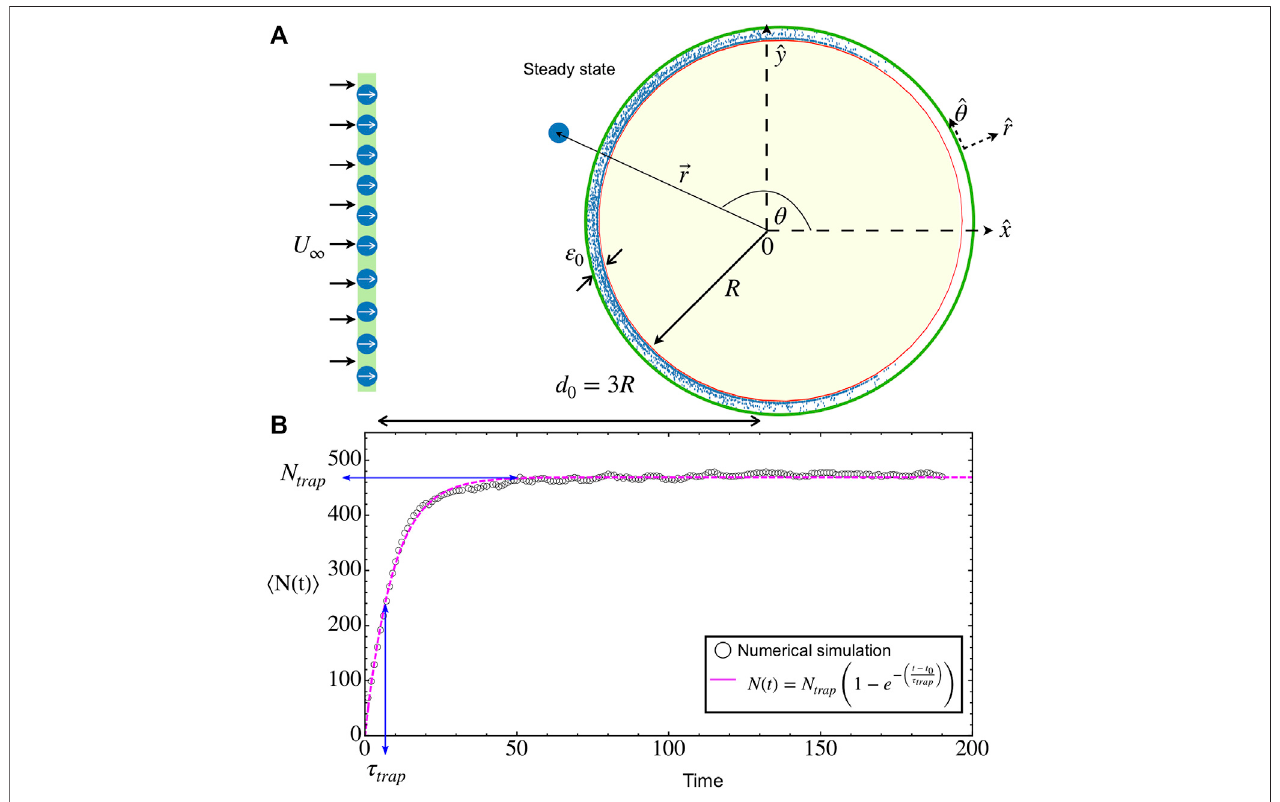
FIGURE 1 | Microbial adhesion on a circular obstacle. (A) Snapshot of a transient state (Brownian deposition): Microswimmers are released in waves at a fi xed distance3 R fromtheobstaclecenterwhiletheyareimmersedinaconstantupstream fl ow U ∞ ^ x .Whenmicroswimmers(bluepoints)comeintocontactwiththeobstacle, theyexploreitssurfaceformingdifferentbacteriallayersontheadhesionspace,delimitedbytheoutergreencircle,atadistance ε 0 fromthesurface. (B) Characterization of the steady state: The average bacterial number on the adhesion space 〈 N ( t ) 〉 increases monotonically on time until it saturates. It is well fi tted to the expression 〈 N ( t ) 〉 (cid:2) N [ 1 − e −( t − t 0 ) / τ trap ] , which allows to compute two relevant observables: the steady state number of trapped particles N trap determines how fast the steady state is